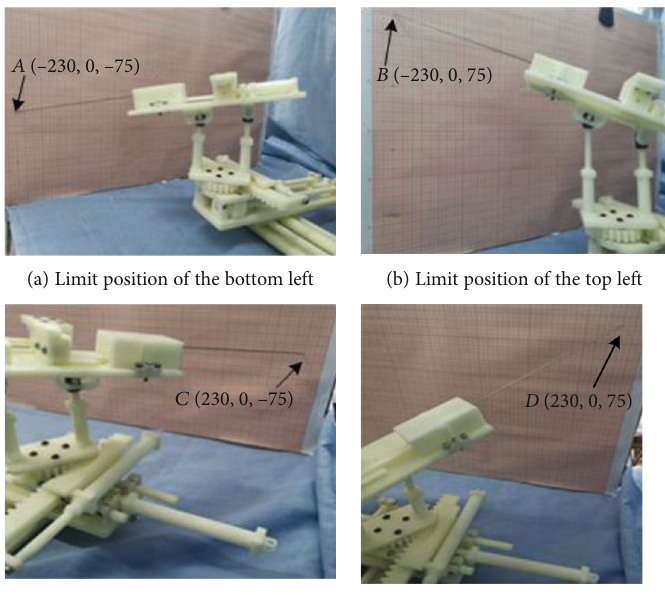
Figure 20: Vertex position.